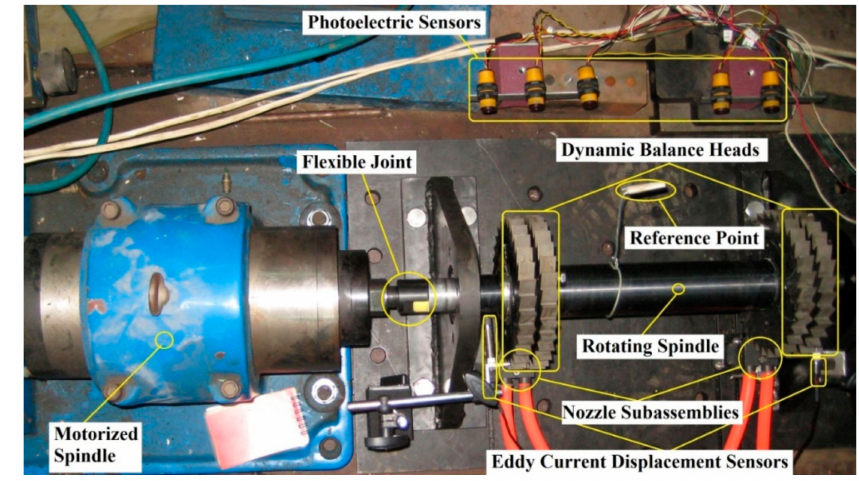
Figure 8. Picture of the experimental system.